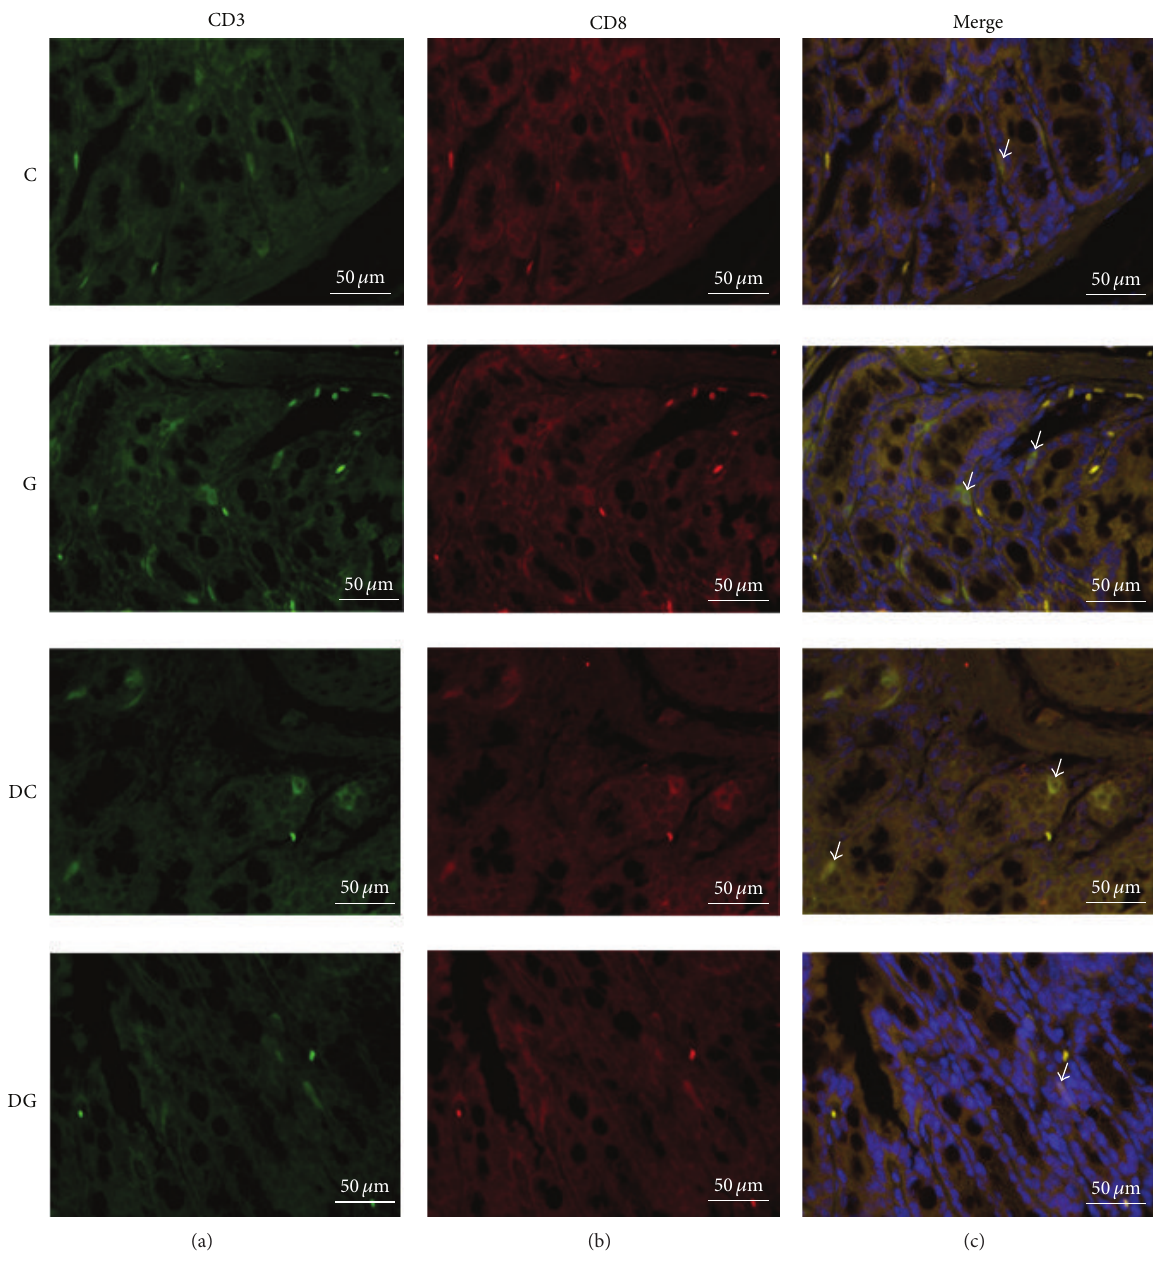
Figure 10: Representative immunofluorescence images of cytotoxic T cells. In the left column, cell surface antigens were stained for CD3 (green, FITC), and the staining of CD8 cells (red, rhodamine) is illustrated in the middle column. The nucleus is stained with DAPI (blue), and the last column presents a colocalized fluorescence image of CD3 + CD8 + T